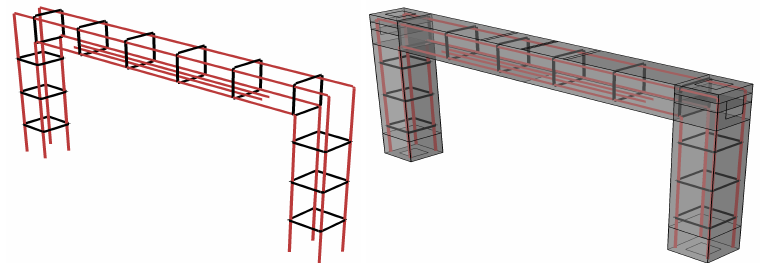
Figure 3. F0, Rebar layout and geometrical